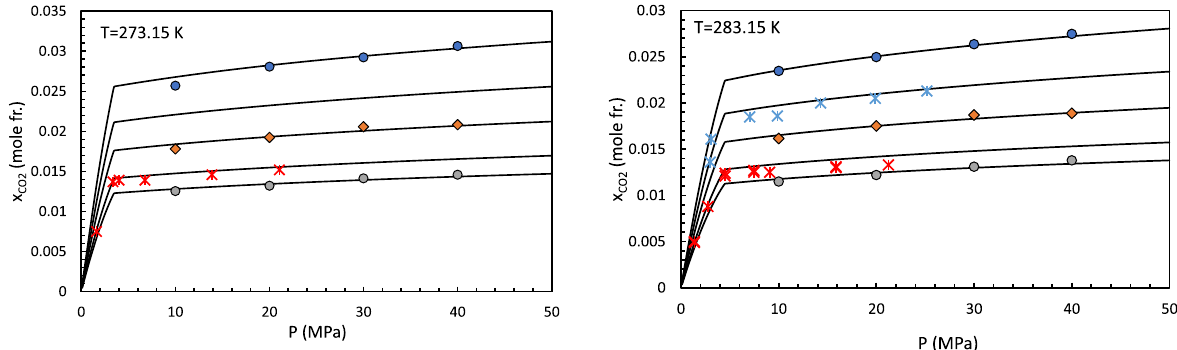
Fig. 3. Predicted and experimental CO 2 solubility in aqueous sodium chloride. Black lines: predictions using the CPA-EoS model.